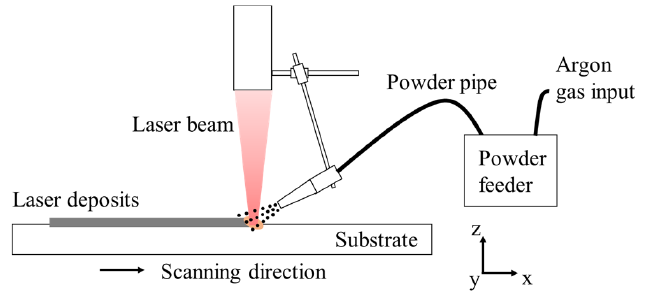
Figure 1. Schematic diagram of the laser deposition process with lateral powder feeding. Table 2. Four sets of experiments carried out in the study. Conditions Forced Cooling (F) Natural Cooling (N) Circular laser beam spot with a Gaussian Circular beam with Circular beam with distribution of power density (C) forced cooling (CF) natural cooling (CN) Square laser beam spot with an uniform power Square beam with Square beam with density in one direction and a Gaussian forced cooling (SF) natural cooling distribution in another (S)